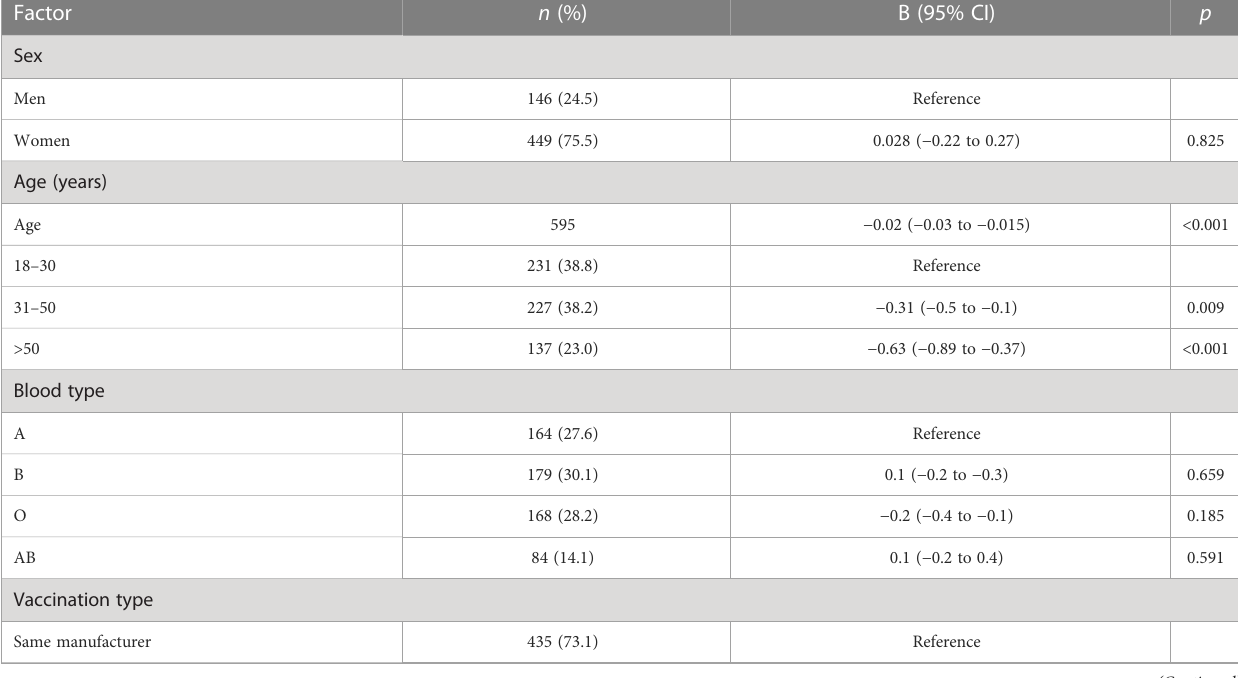
TABLE 2 Factors associated with the neutralization antibody concentration after the administration of the Chinese inactivated COVID-19 vaccine. Factor n (%) B (95% CI) p